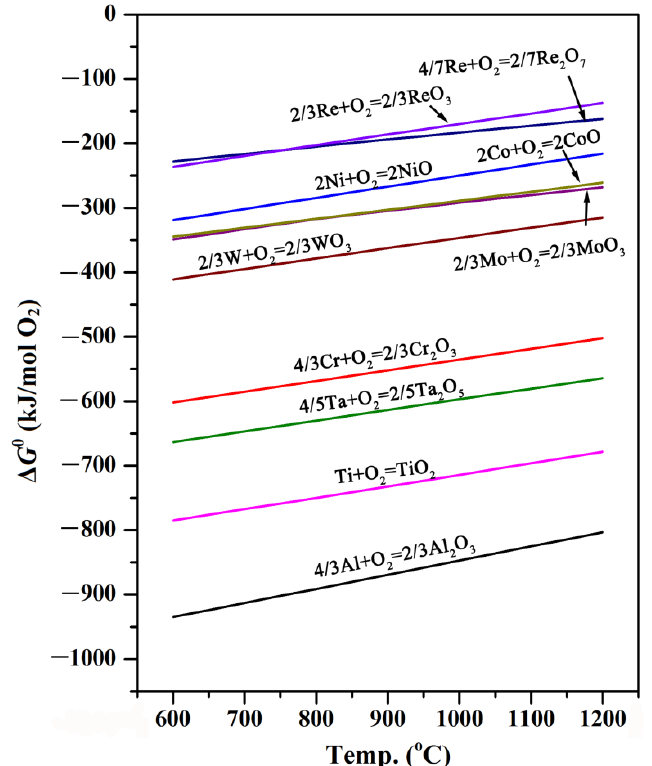
Figure 13. Standard free energy of formation of oxides. The diagram was plotted using data from HSC Chemistry ® version 6.0.